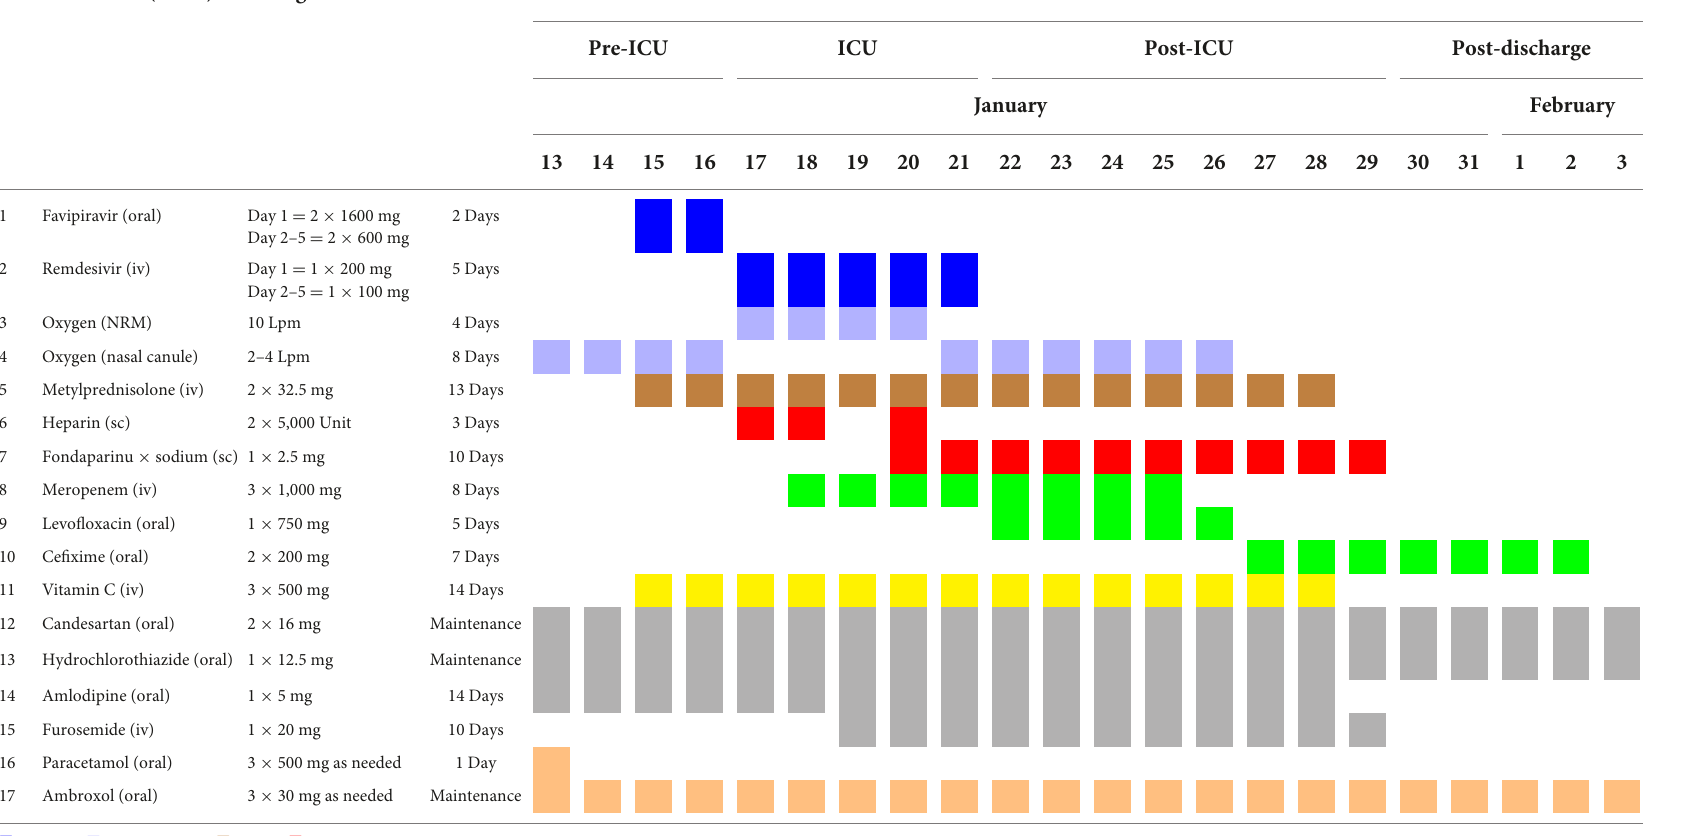
TABLE 2 Timeline of treatments provided during infection episode